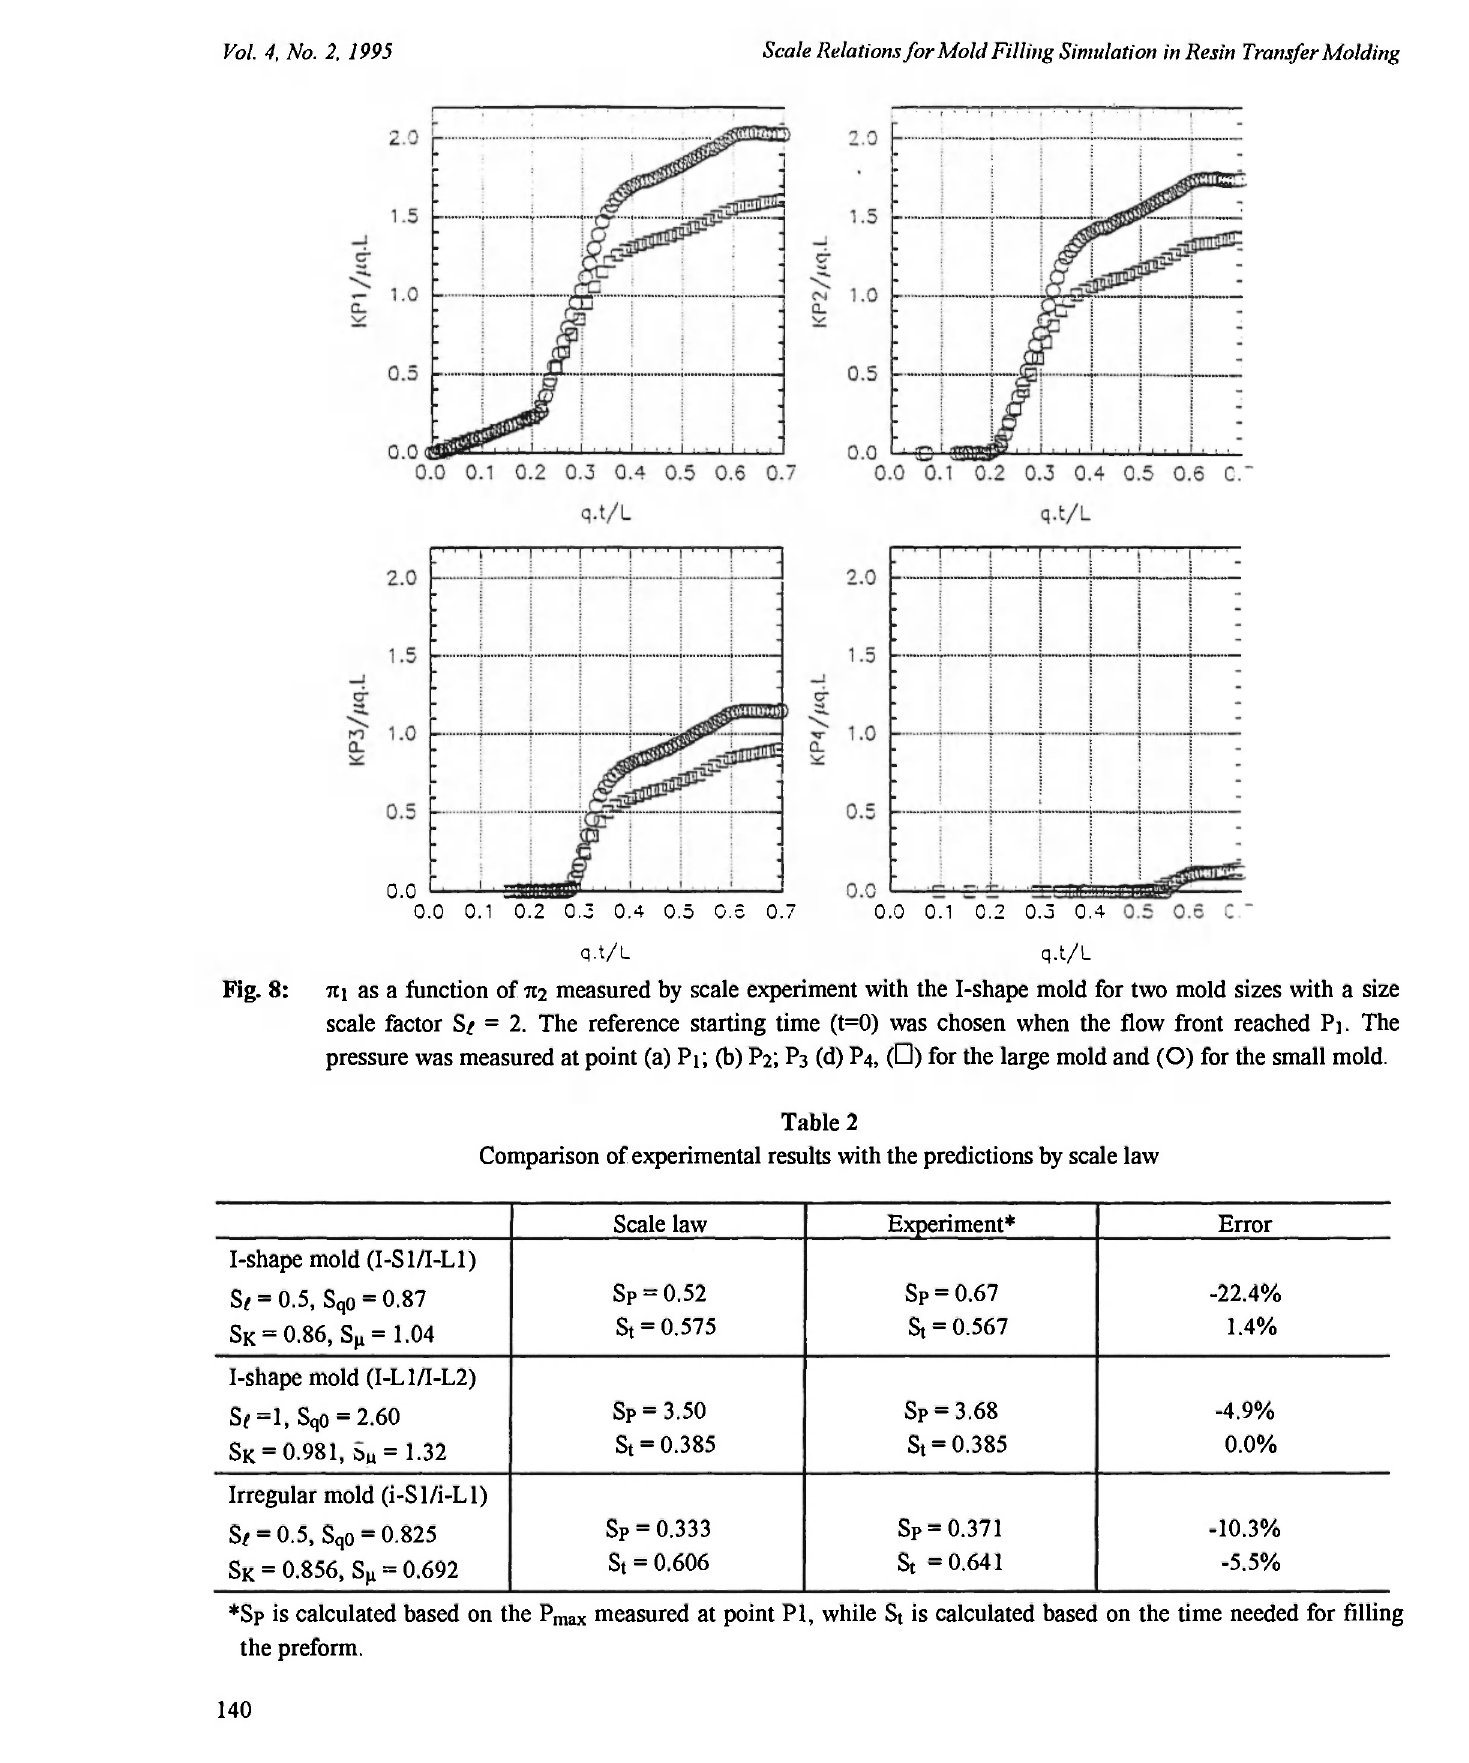
Comparison of experimental results with the predictions by scale law